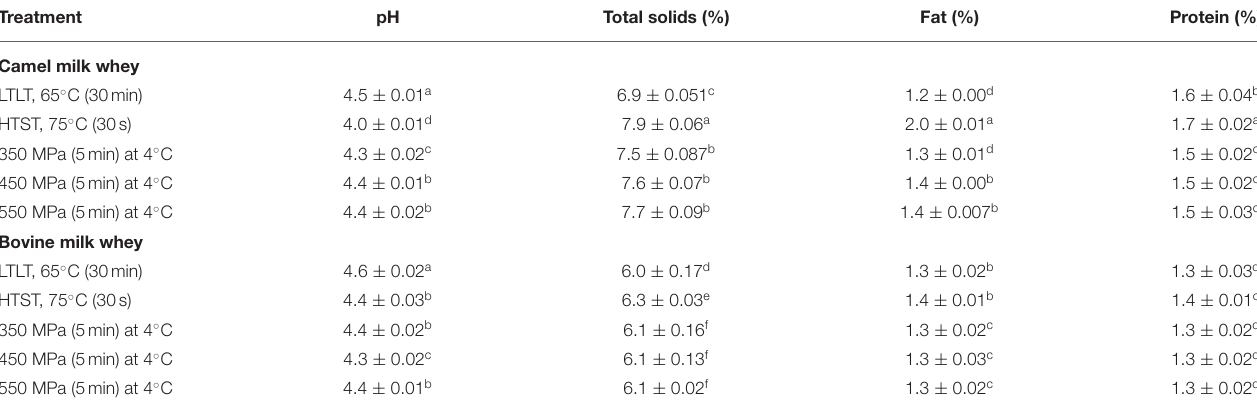
TABLE 5 | Chemical of camel and bovine milk whey proteins ( n = 3). Treatment pH Total solids (%) Fat (%) Protein (%) Camel milk whey LTLT, 65 ◦ C (30min)